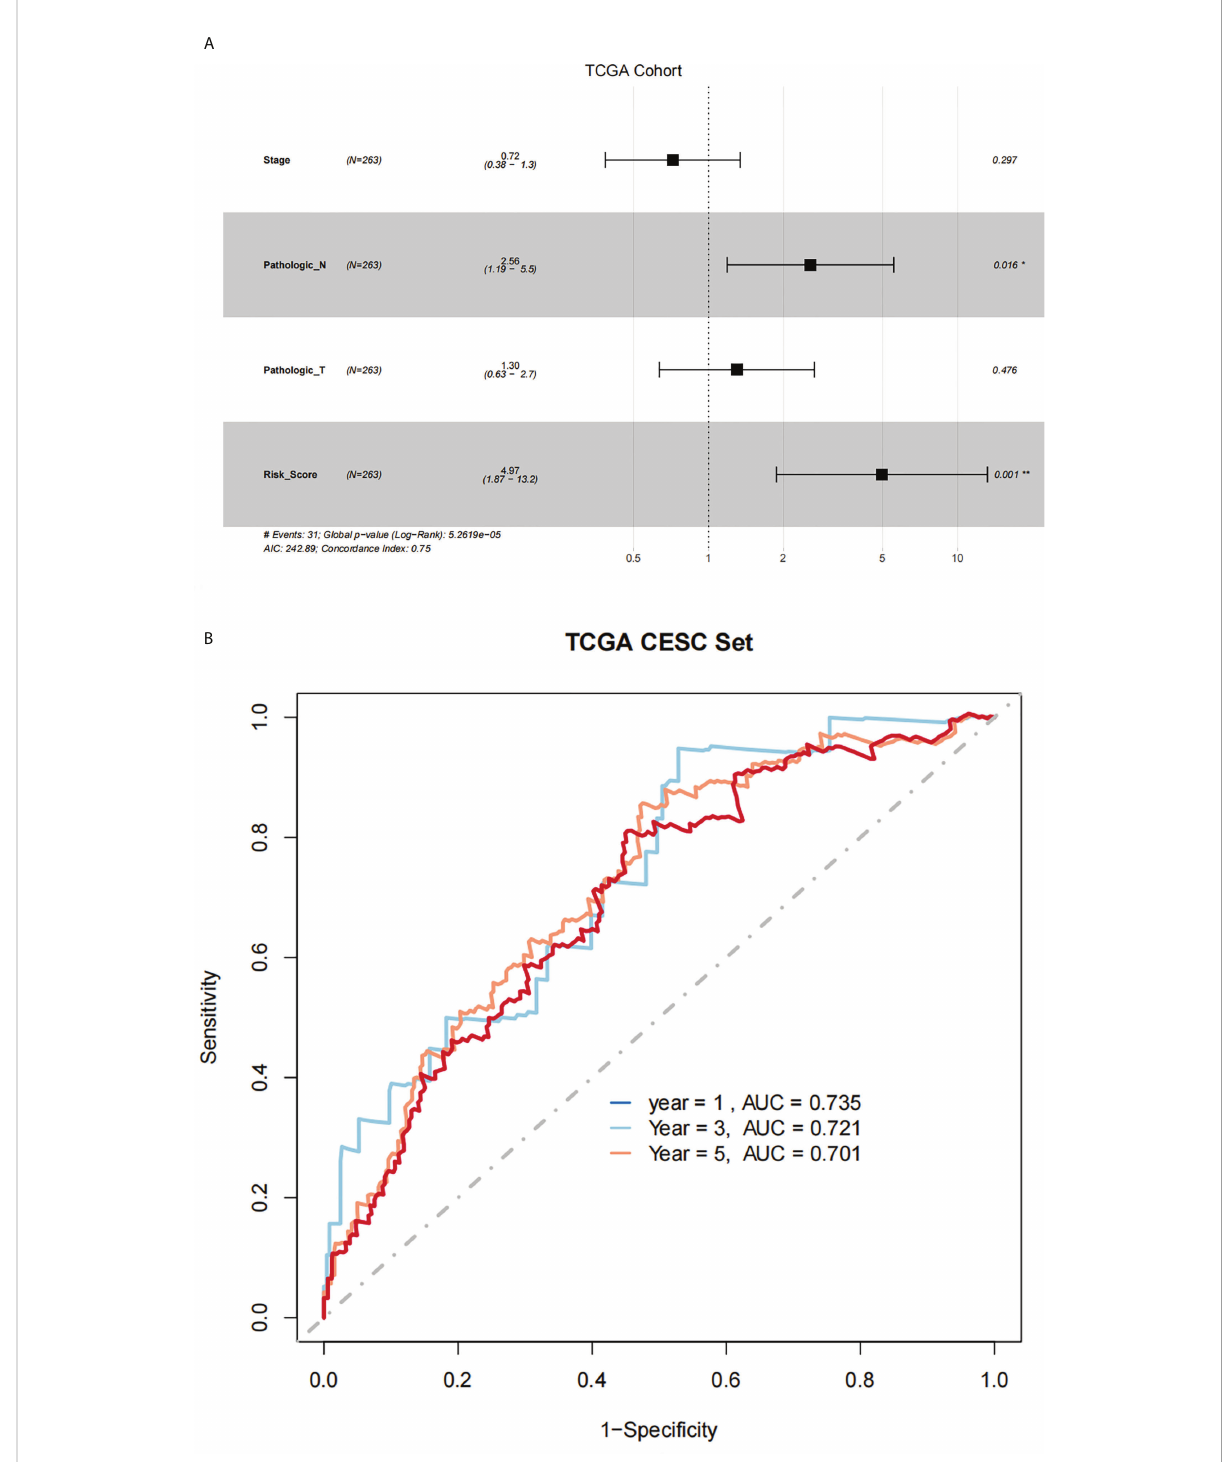
FIGURE 4 There was great predictive performance of the prognostic indicators on the basis of NRLs. (A) The forest plots which represented the results of the multivariate Cox regression analysis in CESC. (B) The areas were respectively 0.735, 0.721, and 0.701, which were under the ROC curves corresponding to 1, 3, and 5 years of